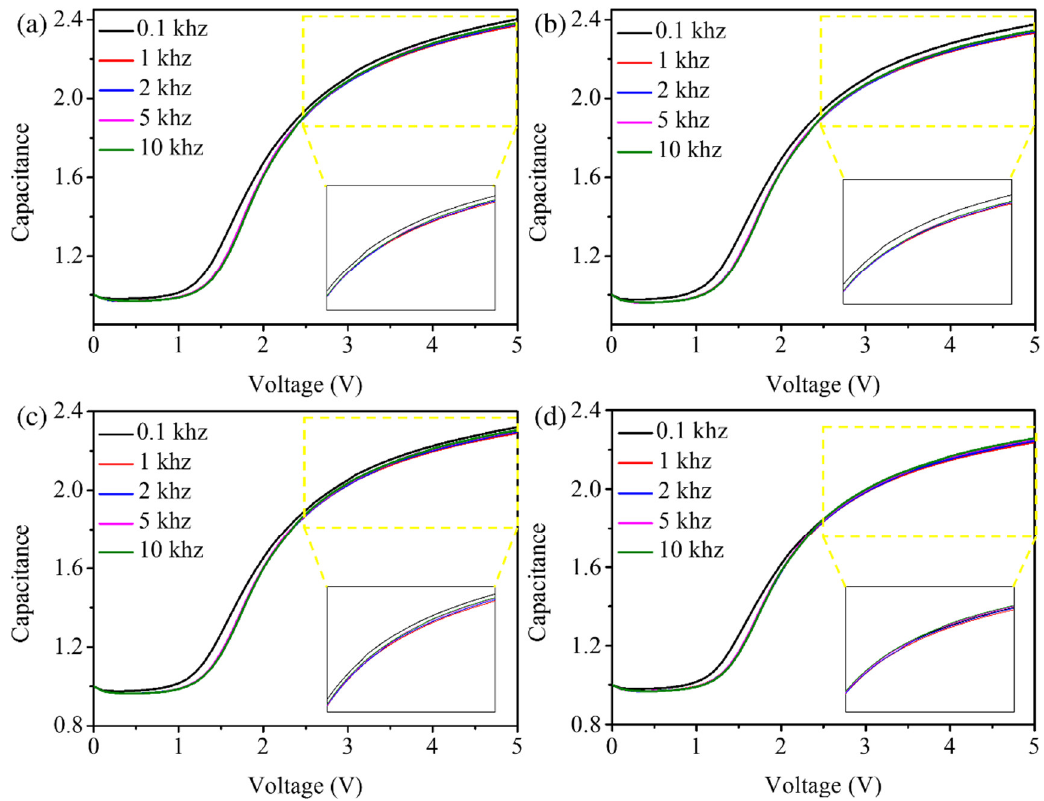
Figure 7. The capacitance-voltage curve of LC sandwiched between ( a ) 0.2 mg/ml, ( b ) 0.5 mg/ml, ( c ) 1.0 mg/ml, and ( d ) 2.0 mg/ml Ag-d-PI composite thin layers.